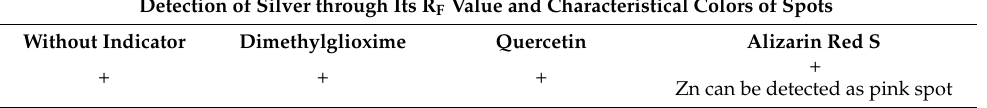
Table 2. Thin-layer chromatography results of detected silver after using different visualization reagents; development by ACN: HCl:H 2 O in 60.00:19.17:20.83 v / v %, on cellulosic precoated plates 20 × 20